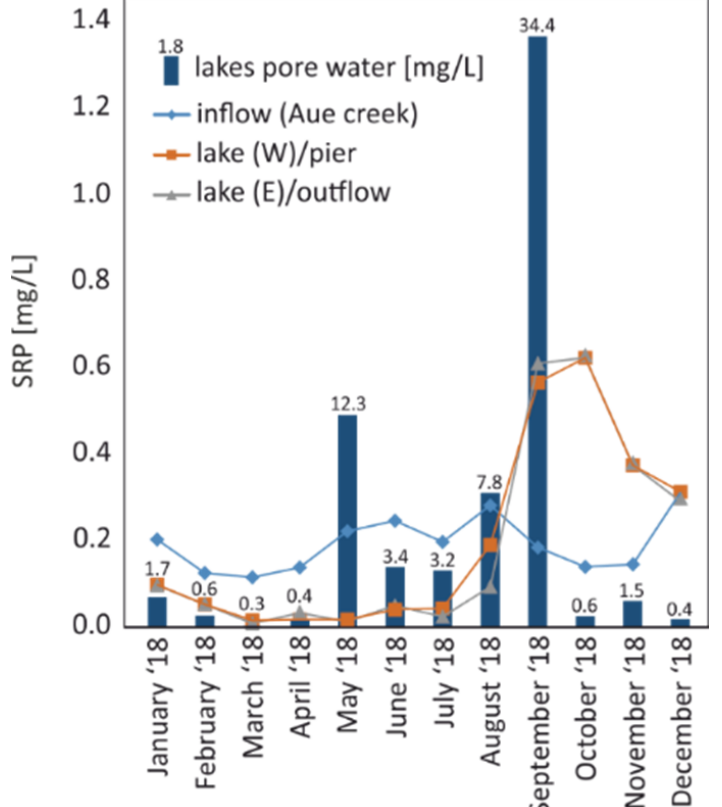
Figure 4. Seasonal variability of soluble reactive phosphate (SRP) in the pore water of Lake Seeburg surface sediments compared to the Aue creek (inflow), the western part (pier), and the eastern part (outflow) in 2018. Note the different scales of surface and pore water. For detailed concentrations, see Table S4.